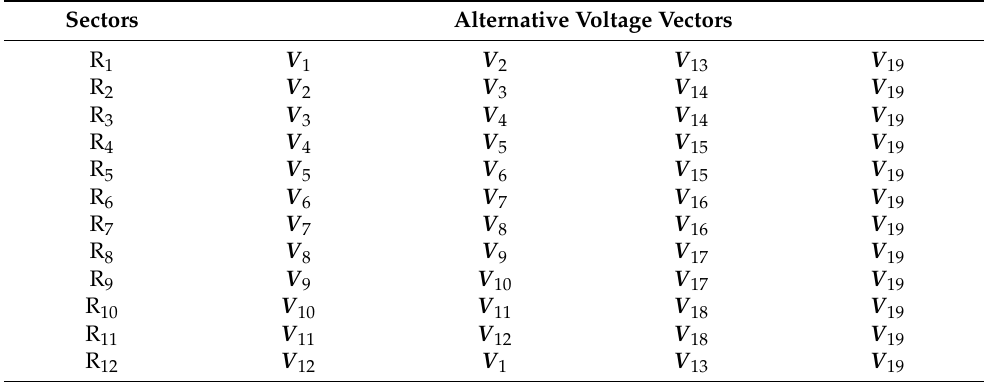
Table 3. Alternative voltage vector in region I. Sectors Alternative Voltage Vectors